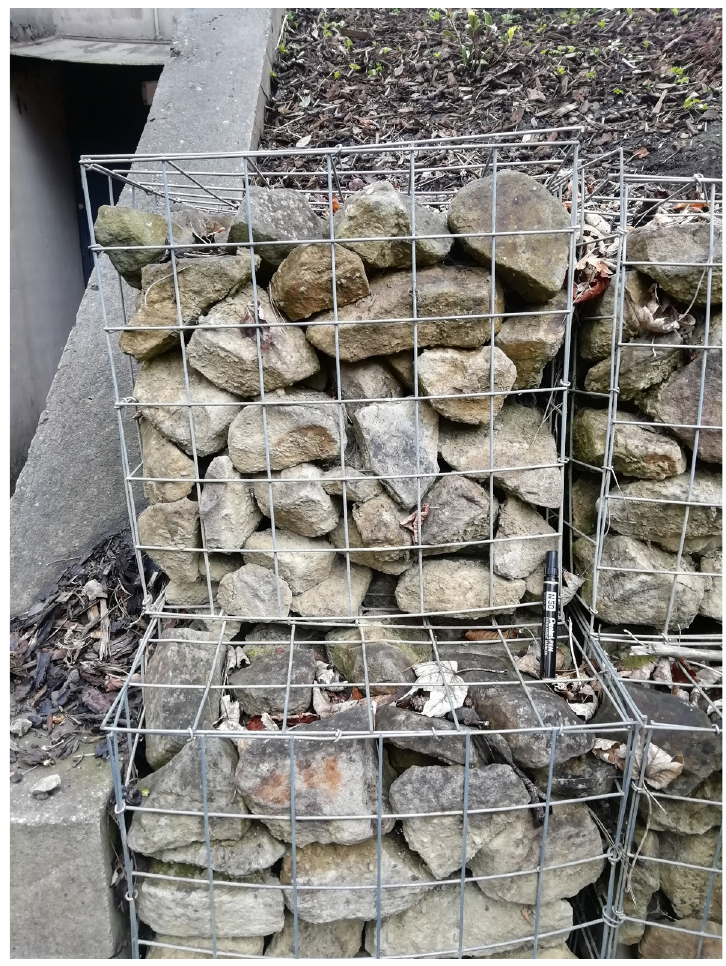
Figure 3. Gabions in use for landscaping. Here filled with blocks derived from Permian age dolostones. The use of such structures to display cobble materials enables the incorporation of such materials into geo-educational structures such as rock